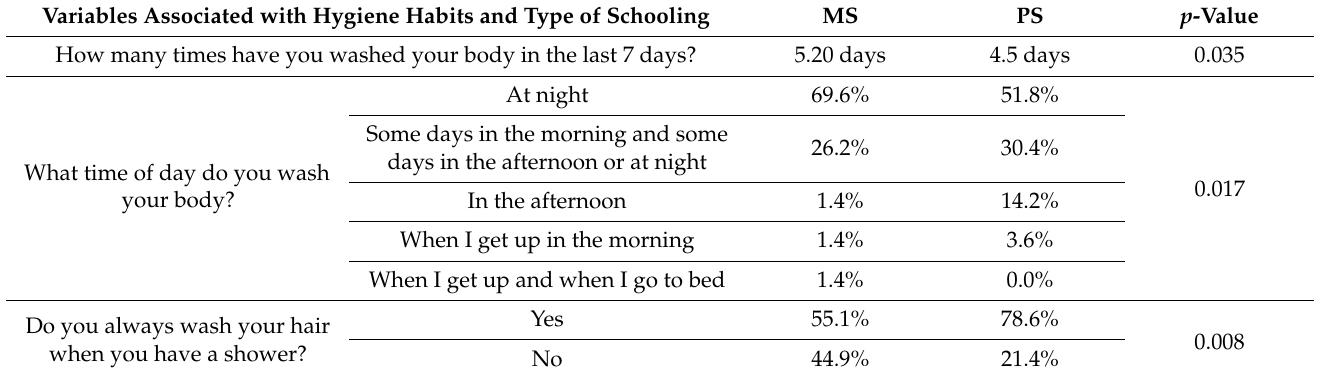
Table 4. Association between hygiene habits and type of